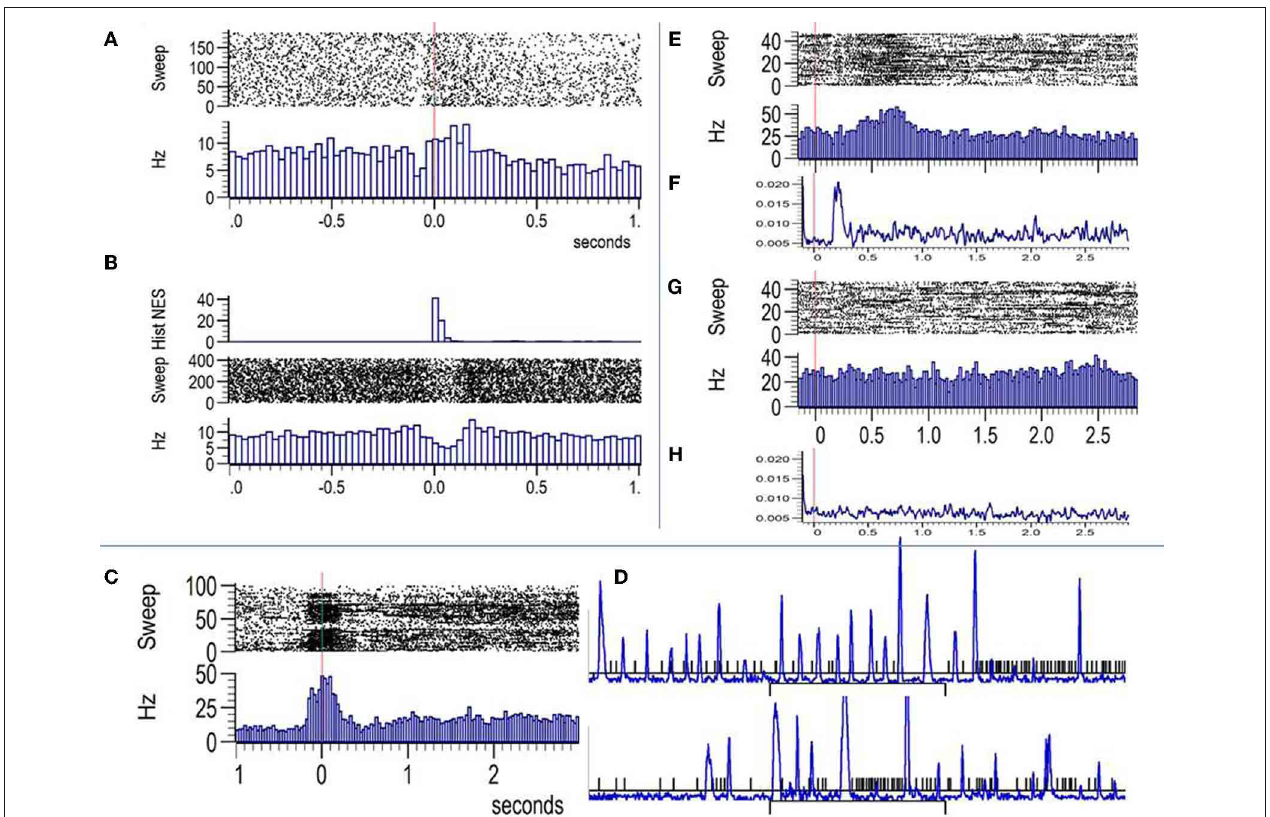
FIGURE 3 | Examples of firing rate modulations by eye movements in the amygdala. (A) Raster plot and PSTH (Hz) aligned by the onset of the images (vertical red line). The cell shows no image selectivity but a slight increase in firing after image onset. Note the significant decrease in firing that precedes by 100ms the onset of the image. (B) Responses of the same cell aligned by saccades. The top inset shows the histogram of the eye speed. Note that the decrease in firing coincides with periods of increased eye speed (saccades) and a modest yet significant increase in firing is observed during fixations just before and after saccades. (C) A cell placed in the Centromedial nuclei showing bursts during the fixation period just before image onset and the first 100ms after image presentation. (D) The eye speed